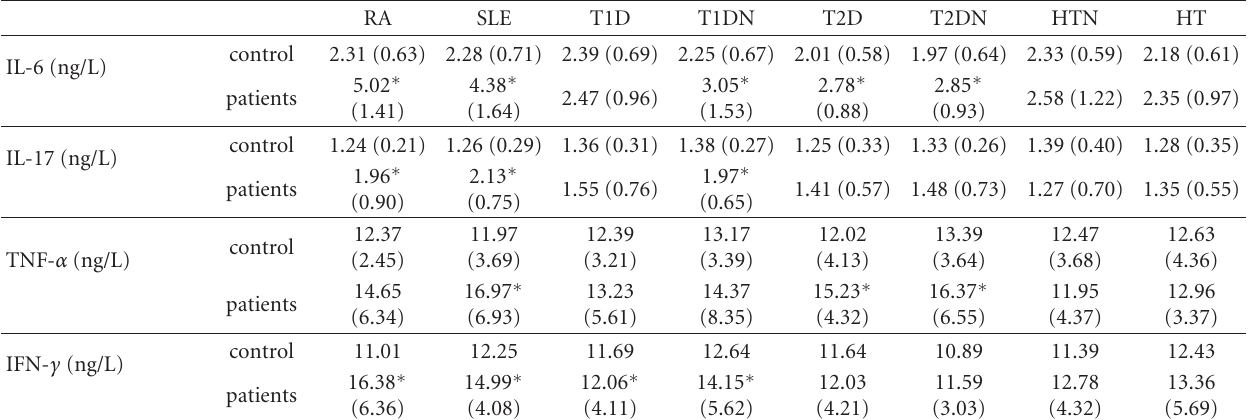
Table 4: The cytokine levels of subjects (mean